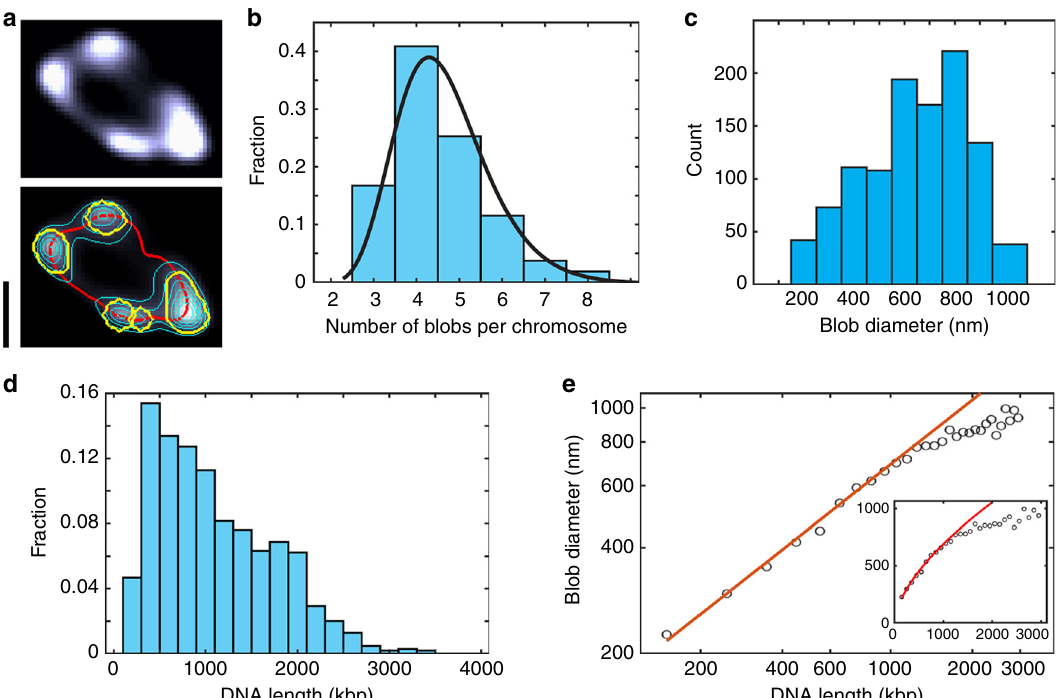
Fig. 2 Domain distribution within the circular chromosome of E. coli . a Example of the automated domain recognition. Top panel, fl uorescent image of a toroidal chromosome (deconvolved image). Bottom panel, same image with ridge line (red), equal-intensity lines (thin cyan lines), and blob boundaries (yellow). Scale bar, 2 μ m. b Number of blobs per chromosome. Black line shows the probability density function (PDF) of a fi tted lognormal distribution. n = 269. c Bar plot of the PDF of the physical size (diameter) of the blobs. d Distribution of domain sizes (DNA length in kbp) in all measured cells. e Blob diameter D (nm) plotted versus the DNA length L (kbp) contained in each blob, on a log-log scale. Circles indicate mean calculated for all cells within a 100 kbp bin size. Red line is a fi t of a power law, D ~ L α with α = 0.60 ± 0.04. Inset shows the same data plotted on linear